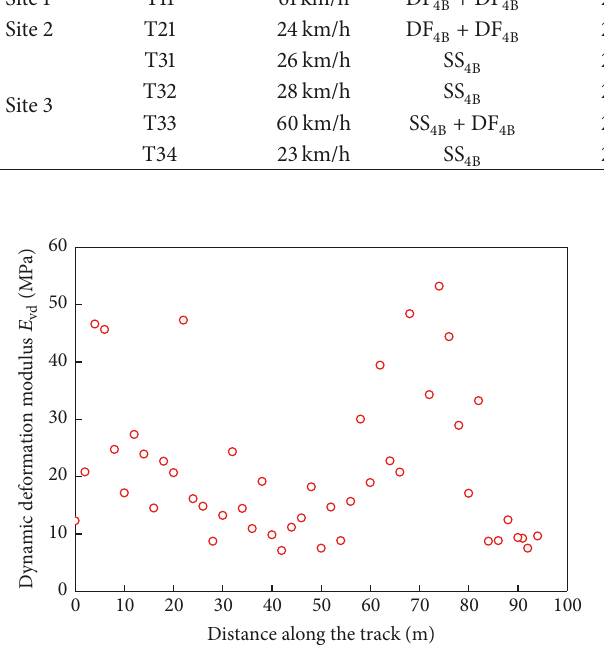
Figure 3: Distribution of dynamic deformation modulus along the track longitudinal direction for site